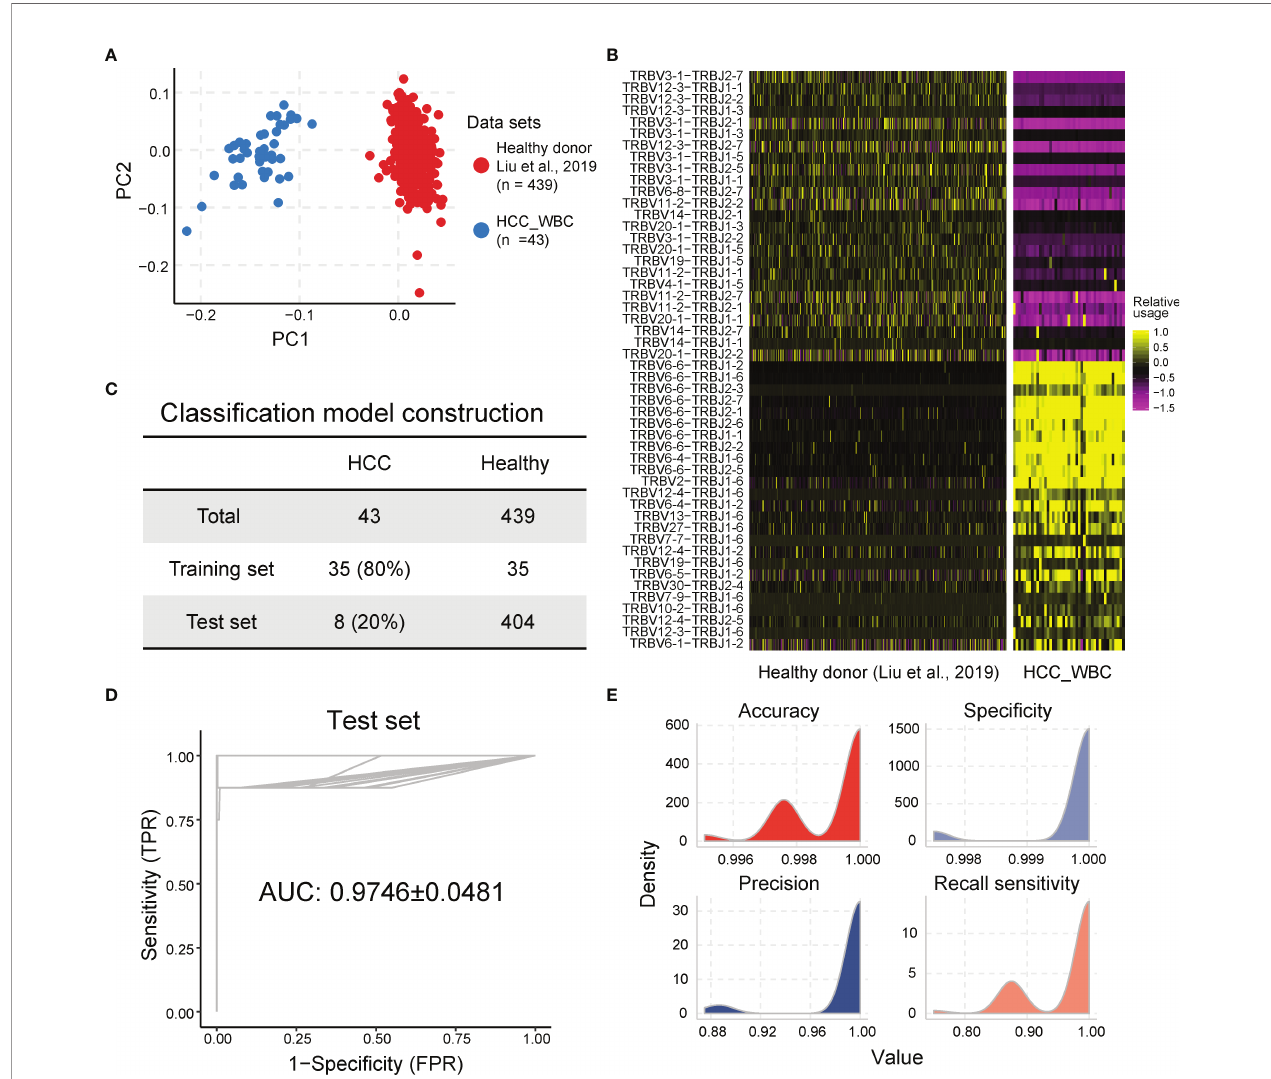
FIGURE 5 | The usage of TCR V b – J b paired genes are the potential biomarkers for HCC diagnosis. (A) Principal component analysis based on TCR V b – J b paired gene usage pro fi le. (B) Heatmap of different TCR V b – J b paired gene usage patterns between HCC patients and healthy donors. The heatmap bar indicates the scaled abundance of TCR V b – J b paired genes. (C) The cohorts of peripheral blood samples from HCC patients and healthy donors were used in LASSO model; 80% (n = 35) of the HCC cohort (n = 43) were randomly selected as the training set and the remaining 20% (n = 8) as the validation set. Healthy donors included in each set were also randomly selected from healthy cohort (n = 439), and their number was the same as the number of HCC patients. (D, E) Performance of diagnosis LASSO model repeated 100 times in training cohort with AUC of 0.9746 ± 0.0481 (average of 100 repeats; left graph) and sensitivity of 0.9675 ± 0.0603, speci fi city of 0.9998 ± 0.0007, accuracy of 0.9992 ± 0.0013, and precision of 0.9908 ± 0.0311 (average of 100 repeats; right graph). AUC, under the curve; TPR, true-positive rate; FPR, false-positive rate. The ROC and average AUC of 100 repeats using LASSO models are shown in the left panel. The density for accuracy, speci fi city, precision, and sensitivity of the prediction results from 100 repeats using LASSO model is shown in the right panel. TCR, T-cell receptor; HCC, hepatocellular carcinoma; LASSO, least absolute shrinkage and selection operator; AUC, area under the curve; ROC, receiver operating